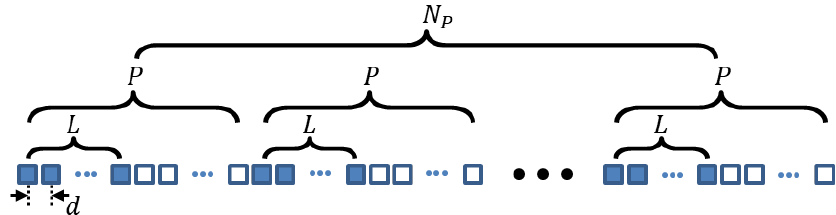
Figure 1. Sparse linear array layout. The array comprises N P blocks. In each block having P elements, only the subarray consisting of L consecutive elements (blue colored squares) in each block is active.